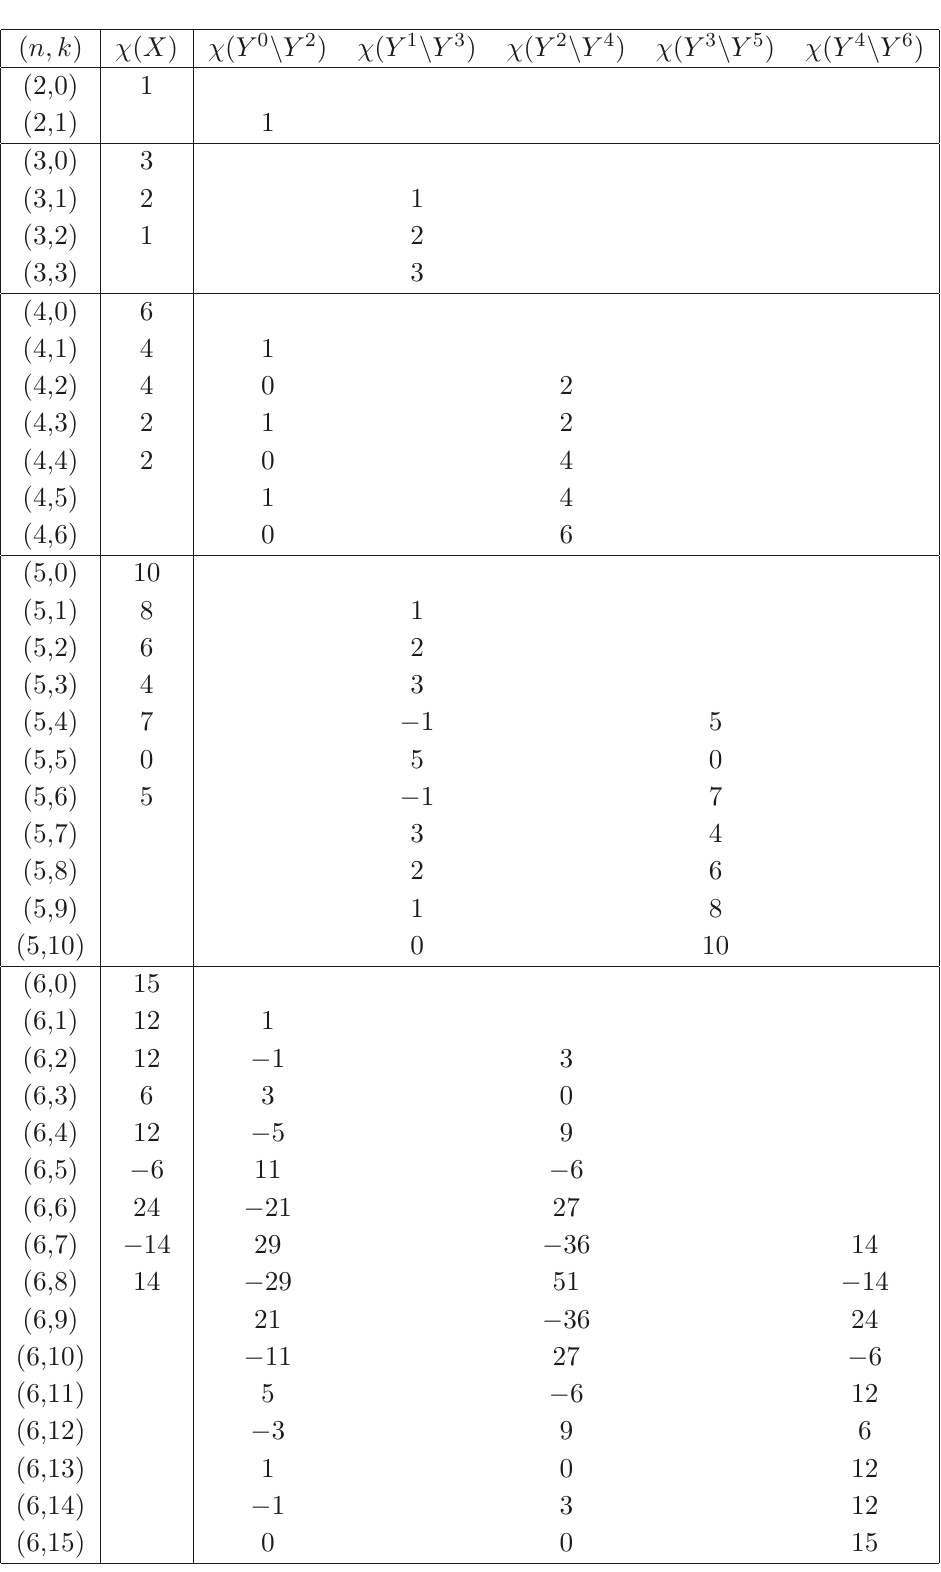
Table of Euler characteristics: the U(2)